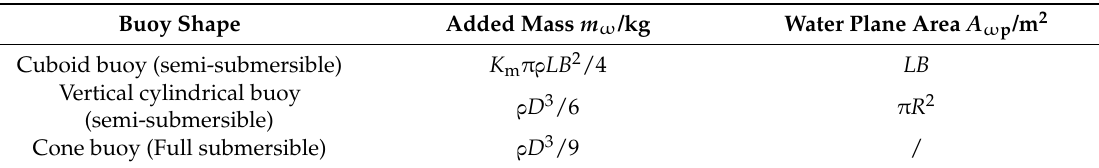
Table 1. Added mass and surface waterplane area for several buoy shapes.